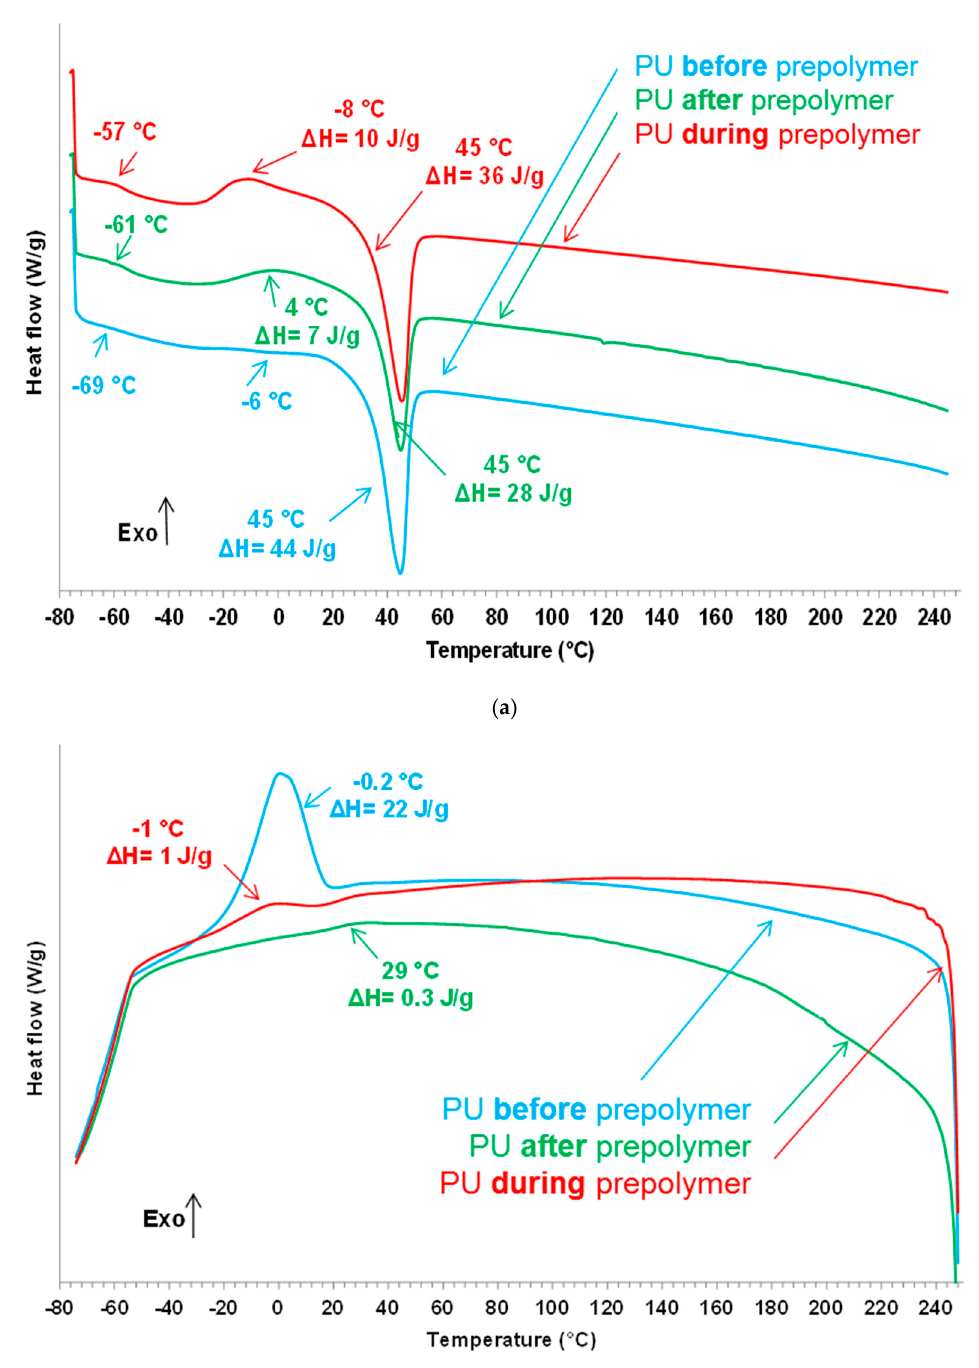
Figure 10. Differential scanning calorimetry (DSC) traces of the PU films: ( a ) second DSC heating run; ( b ) DSC cooling run.